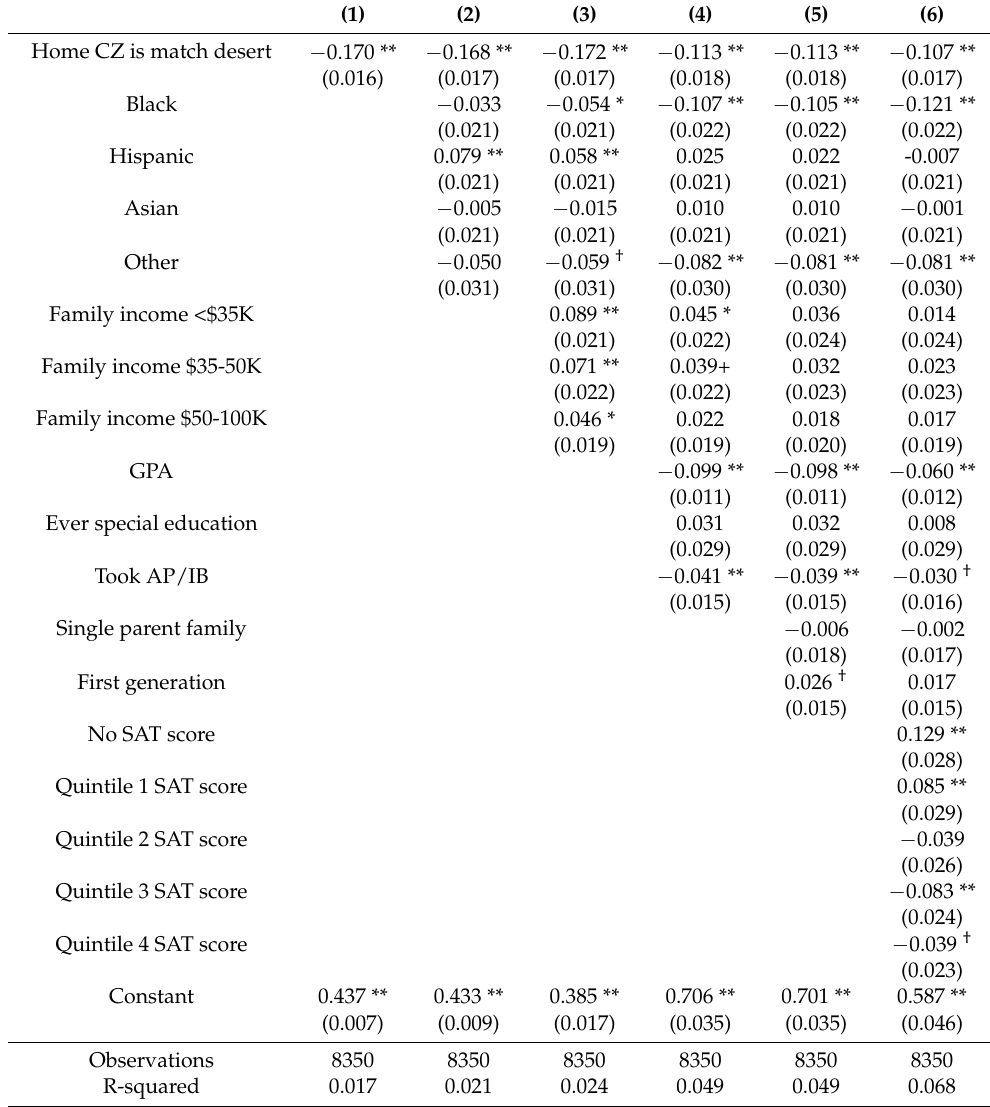
Table A6. Relationship between living in match desert and enrolling in a strict academic-match